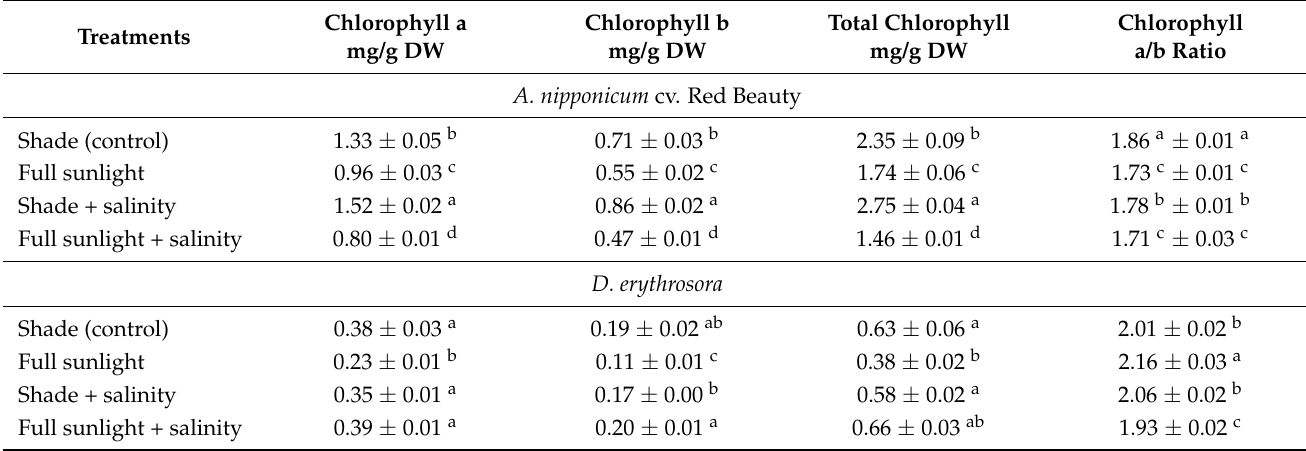
Table 3. Effect of abiotic stresses on chlorophyll pigment content of two hardy ferns. Within a column means followed by the same lowercase letter are not significantly different at p ≤ 0.05 (ANOVA, Tukey’s HSD post hoc